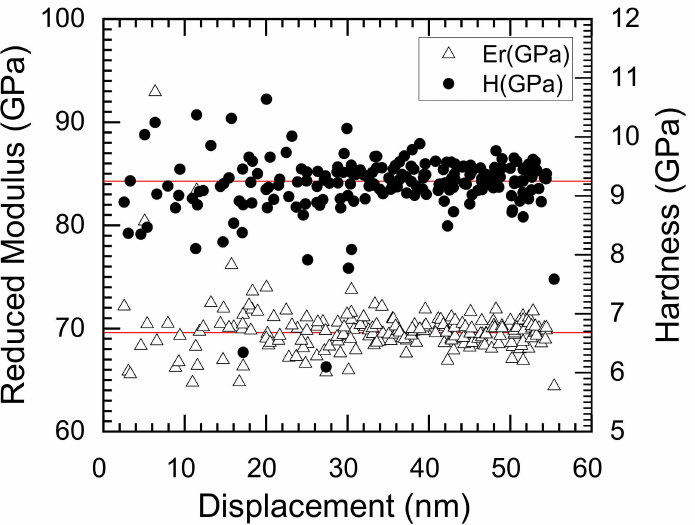
Figure 2. Calibration measurements for reduced modulus ( (cid:78) ) and hardness ( • ) along the depth of the reference quartz